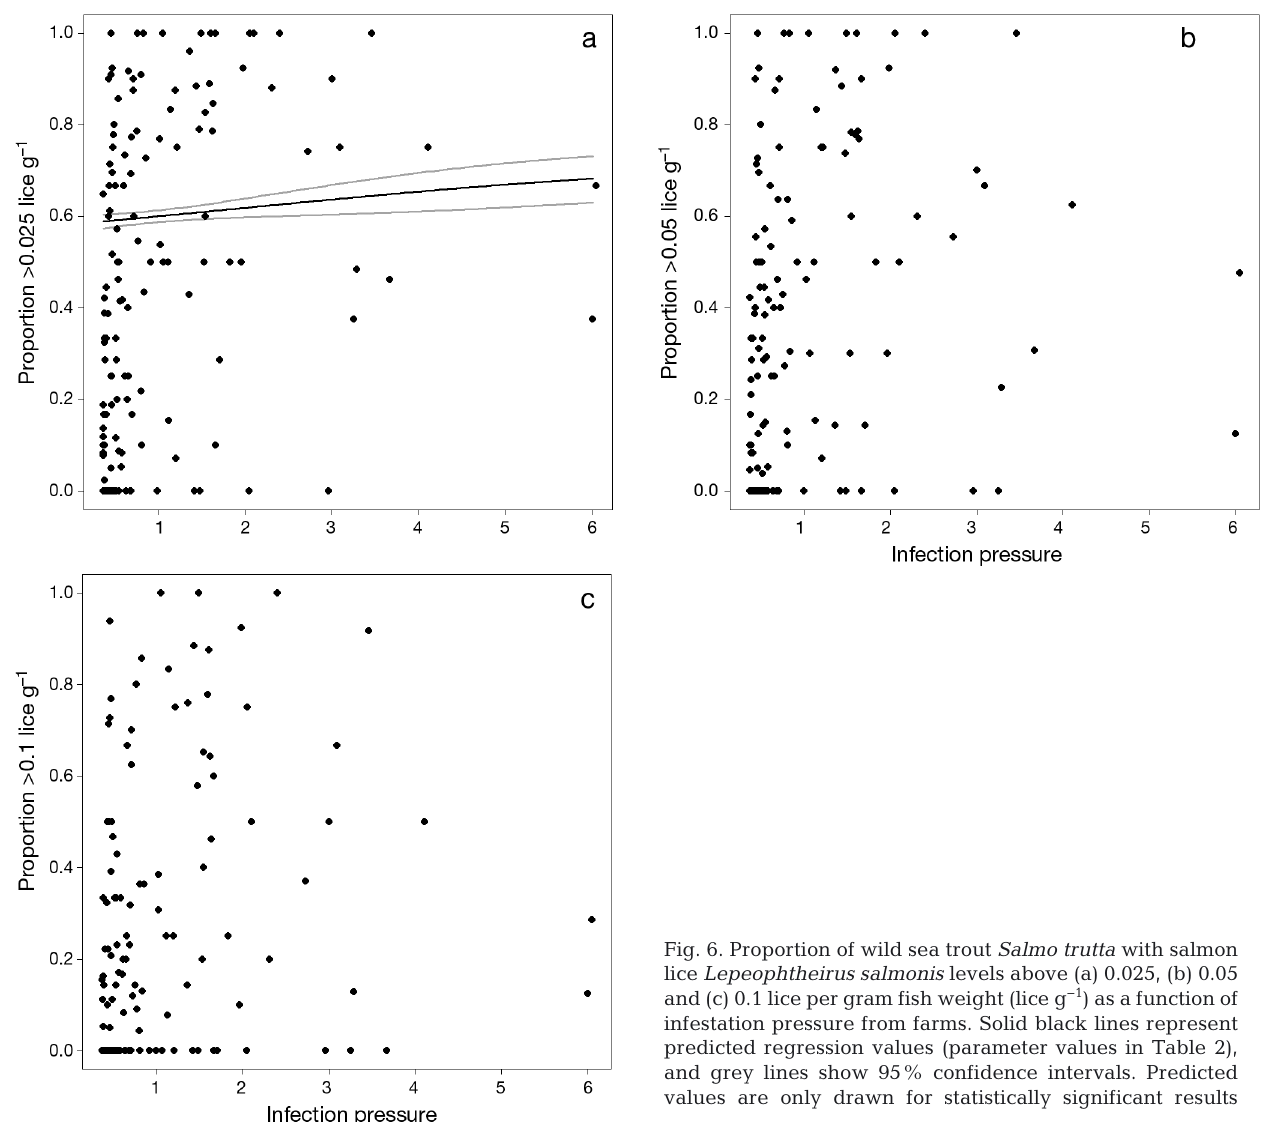
Fig. 6. Proportion of wild sea trout Salmo trutta with salmon lice Lepeophtheirus salmonis levels above (a) 0.025, (b) 0.05 and (c) 0.1 lice per gram fish weight (lice g −1 ) as a function of infestation pressure from farms. Solid black lines represent predicted regression values (parameter values in Table 2), and grey lines show 95% confidence intervals. Predicted values are only drawn for statistically significant